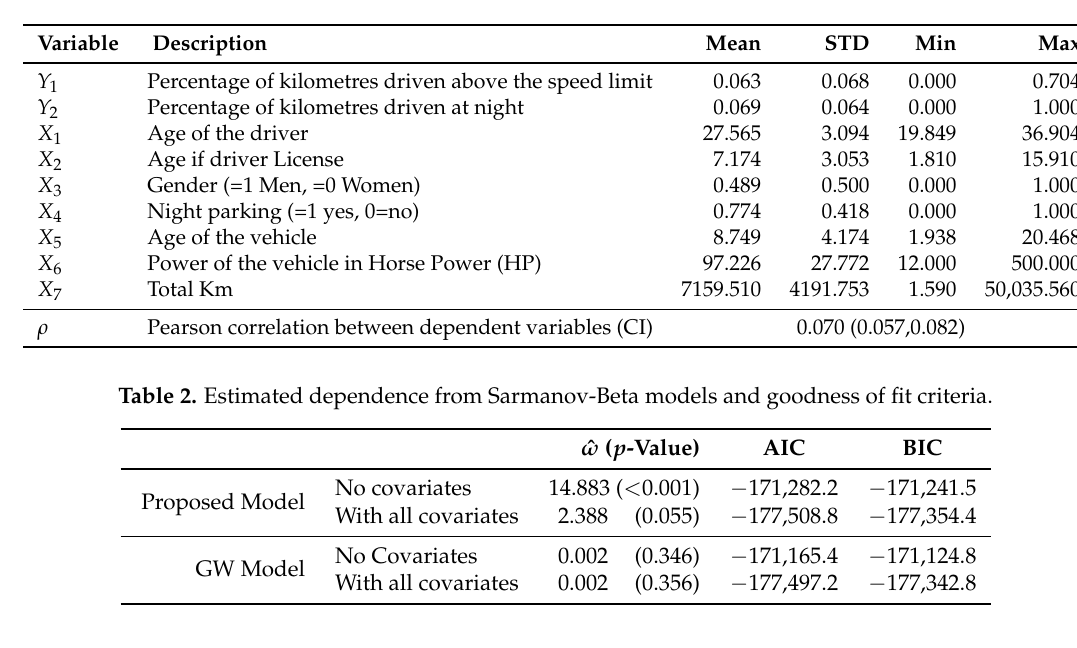
Table 1. Definition of variables and descriptive statistics: mean, standard deviation (STD), minimum (Min) and Maximum (Max). The last row shows the linear correlation between dependent variables and a confidence interval at the 95% level.